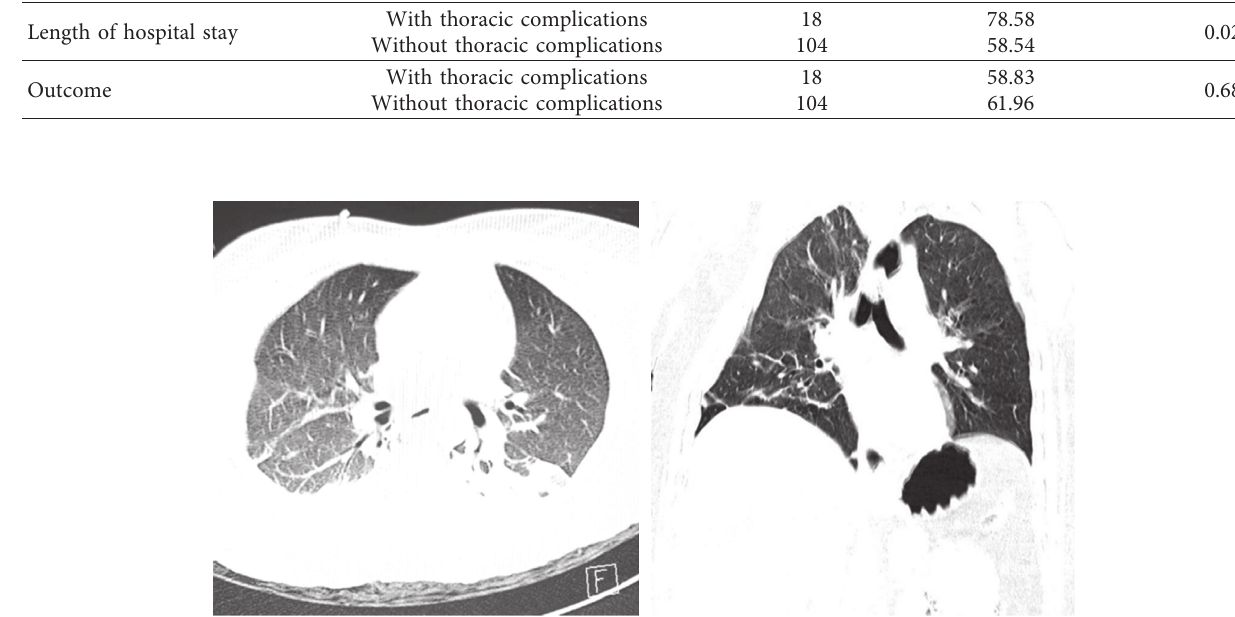
Figure 4: CT scan of COVID-19-positive patients, showing bilateral, subpleural, and peripheral ground-glass opacities, crazy paving appearance, and inter/intralobular septal thickening with air space